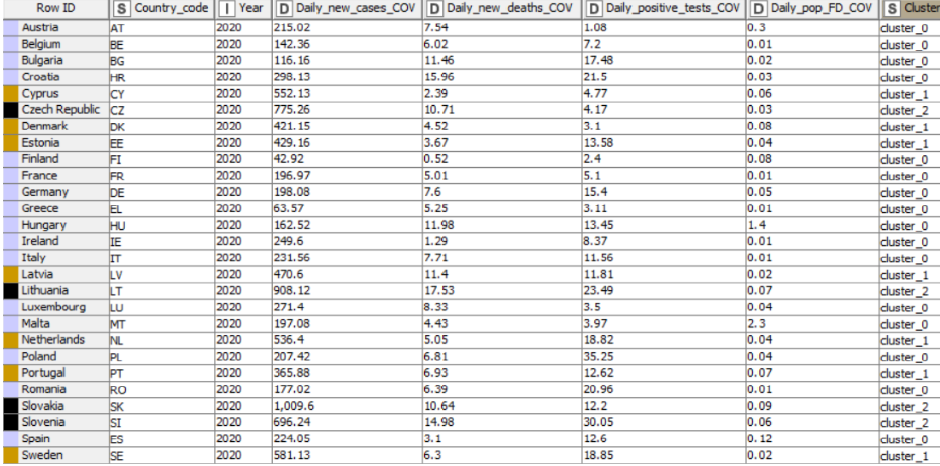
Figure 13. Distribution of countries into clusters, based on COVID-19. Source: authors’ compilation in KNIME analytics platform.